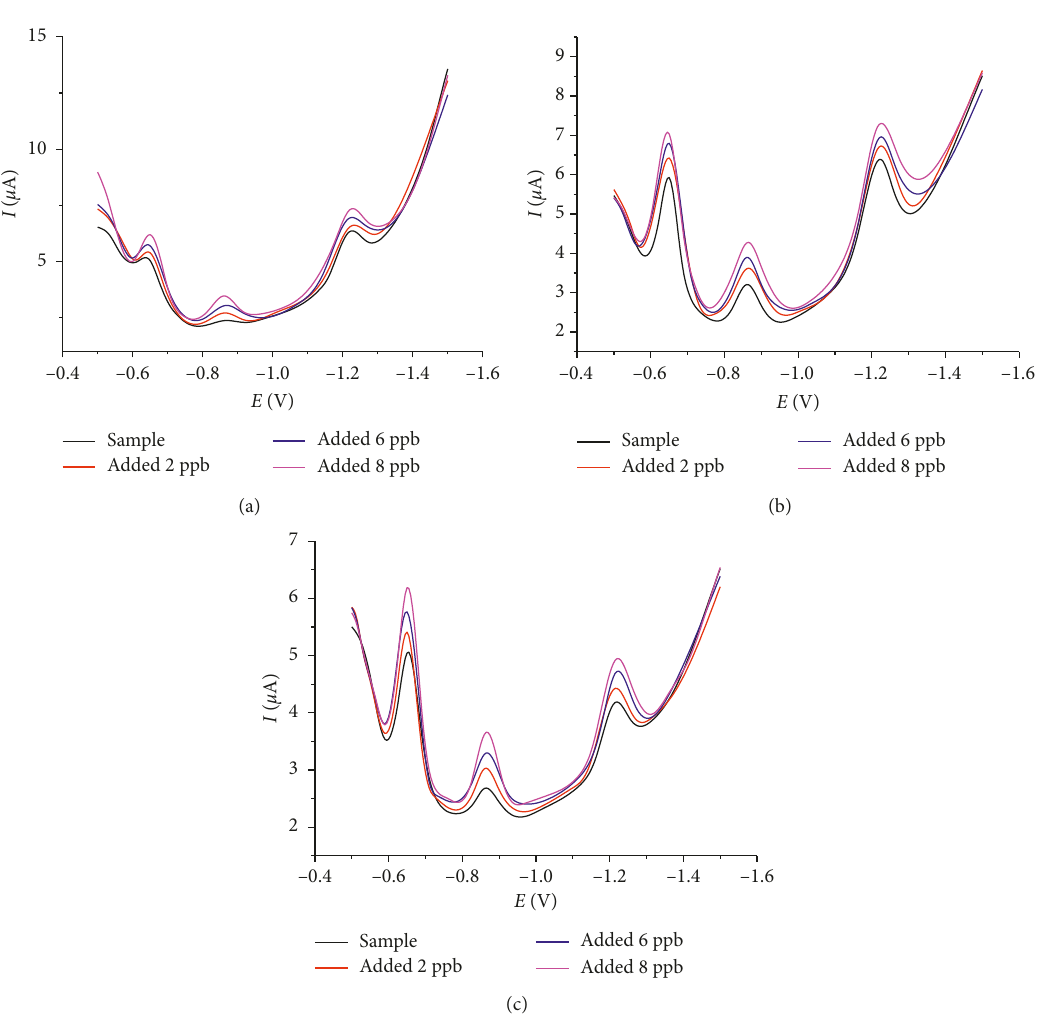
Figure 5: SqW-AdSV voltammograms obtained for the water samples: (a) Cau Rao River, (b) Nam Ly Lake, and (c) Kien Giang River (the same conditions as in Figure